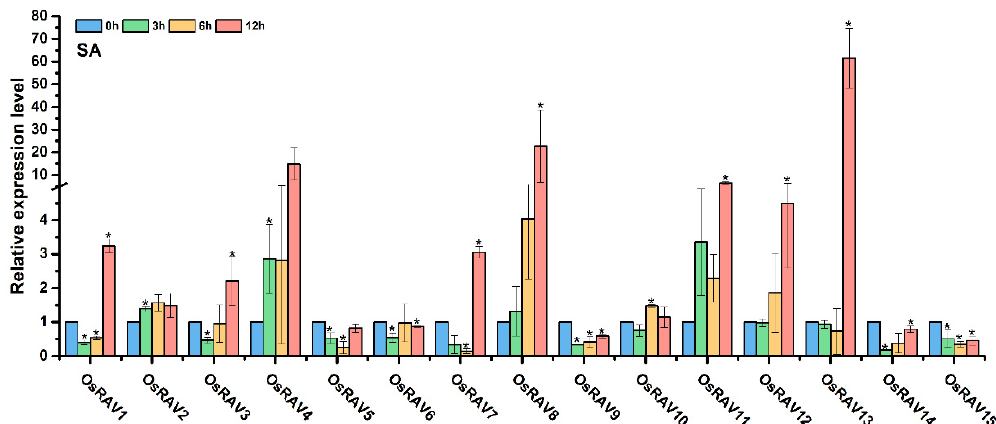
Figure 7. Relative expression level of fifteen RAV genes following SA (500 µ M) treatments and sampled at 0, 3, 6, and 12 h. qPCR data were normalized using OsUBQ5 . Results are the means ± standard deviation (SD) of three biological replicates. * indicates significant difference from the mock control at p ≤ 0.05 by Fisher’s least significant difference tests.